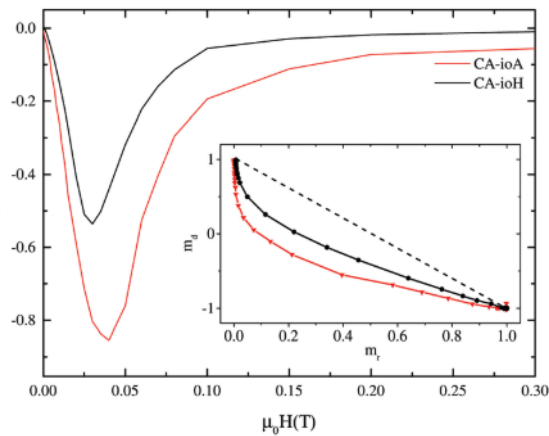
Figure 7. Δ M plots and (inset) Henkel plots of representative’s samples of the CA-io series at 5 K. The figure is reproduced with permission from Blanco-Andujar et al.